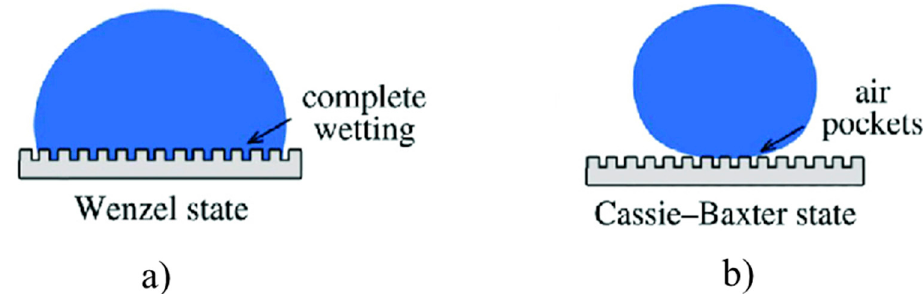
Figure 3. Roughness values of samples before (triangles) and after (circles) the application of the coating. 3.2. Application of Coating The aerograph setting parameters were varied and optimized in order to guarantee uniformity in terms of thickness and weight of the applied coating. Here, as an example, two different setting parameters, labelled as Procedure 1 and Procedure 2 , are described; the corresponding schematics are shown in Figure 4. They